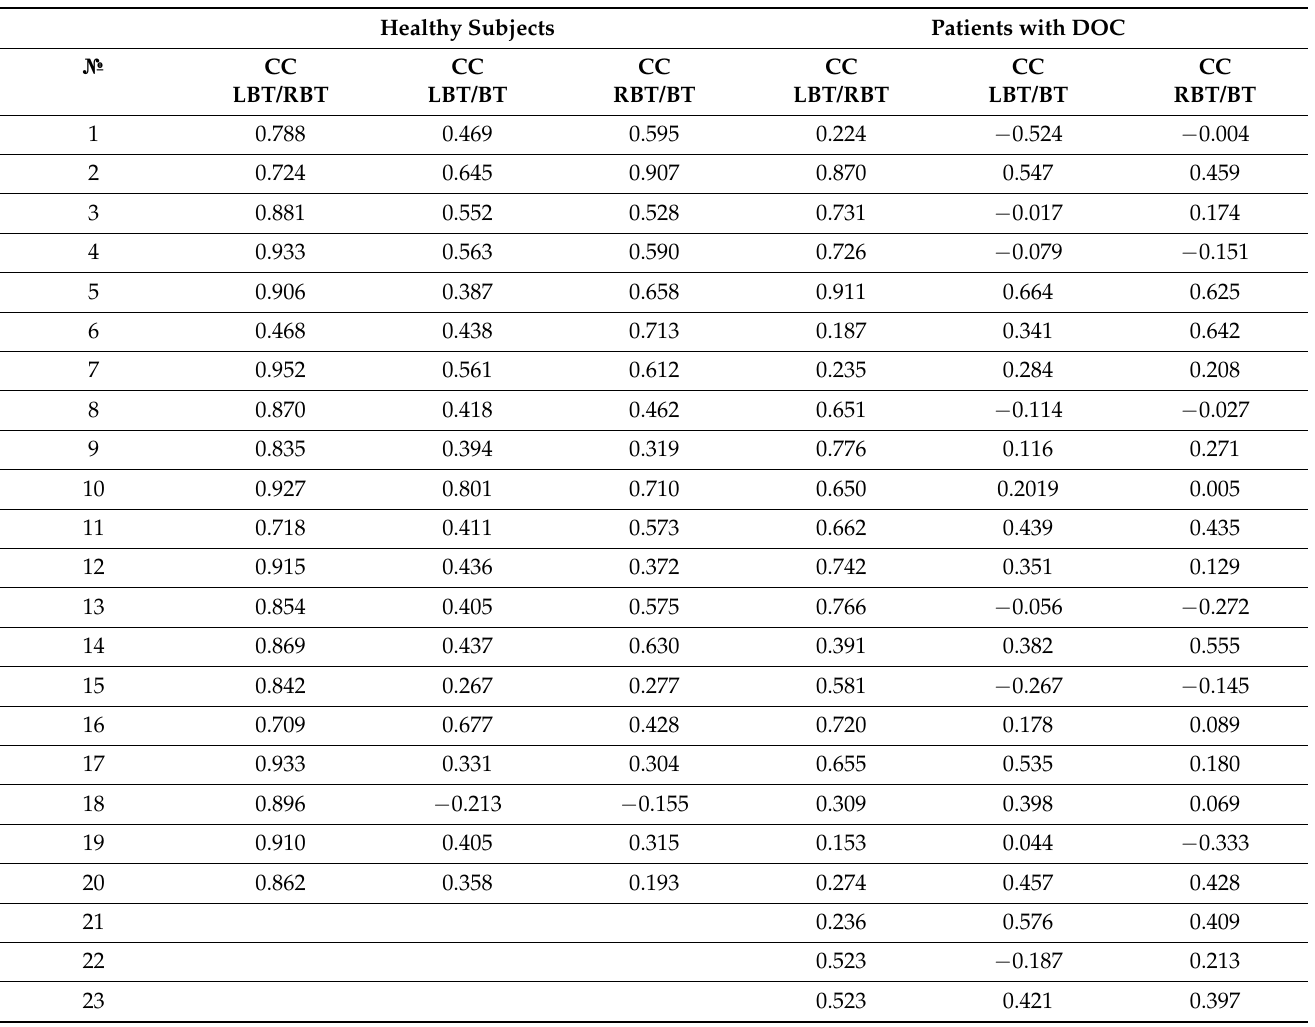
Table 1. CC (correlation coefficient) of temperature changes in the LBT, RBT and BT during the entire period of measurements in healthy individuals and patients with